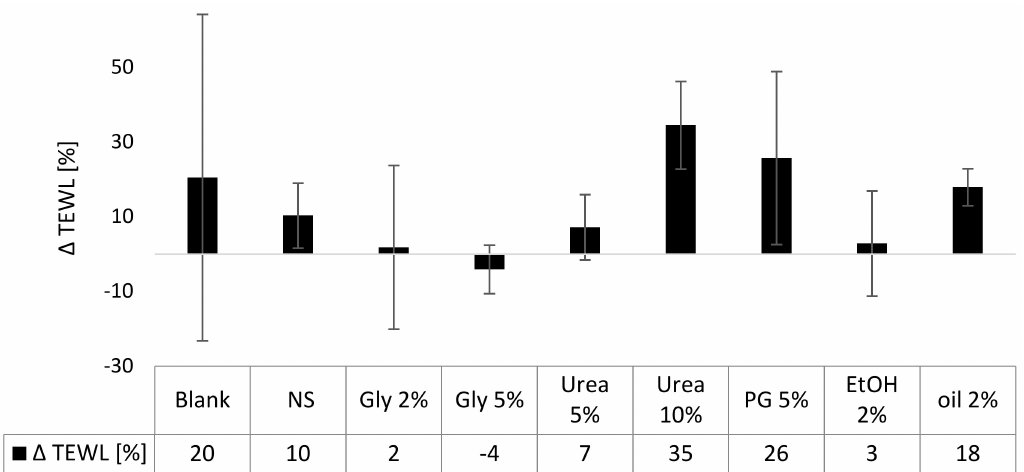
Figure 7. Influence of curcumin nanosuspension without (NS) and with di ff erent excipients on the skin barrier function (TEWL measurements are expressed as ∆ TEWL [%], representing the relative changes in TEWL 6 h after the treatment, compared to the TEWL values prior to the skin treatments).